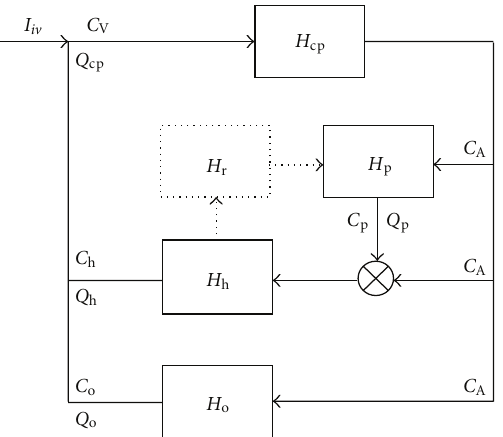
Figure 1: Circulatory model of the system H iv describing drug disposition in a human body after an intravenous bolus dose of a drug. The drug administration is denoted by I iv . The concentration- time profile of the drug in arterial blood denoted with C A . The concentration-time profile of the drug in venous blood denoted with C V . The cardiopulmonary subsystem, describing the drug transport through the heart and lungs, is denoted by H cp . H p is the portal-venous subsystem describing the portal transport of the drug. H h is the hepatic-portal subsystem describing the hepatic transport of the drug. H o is the subsystem describing the drug trans- port through noneliminating tissues. H r is the subsystem describing the enterohepatic cycling. The subsystem H r is shown by a dotted line, to indicate that the enterohepatic cycling is not always present. The symbol ⊗ denotes a summation operator. Q cp , Q p , Q h , Q o are blood flows in the subsystems specified by the